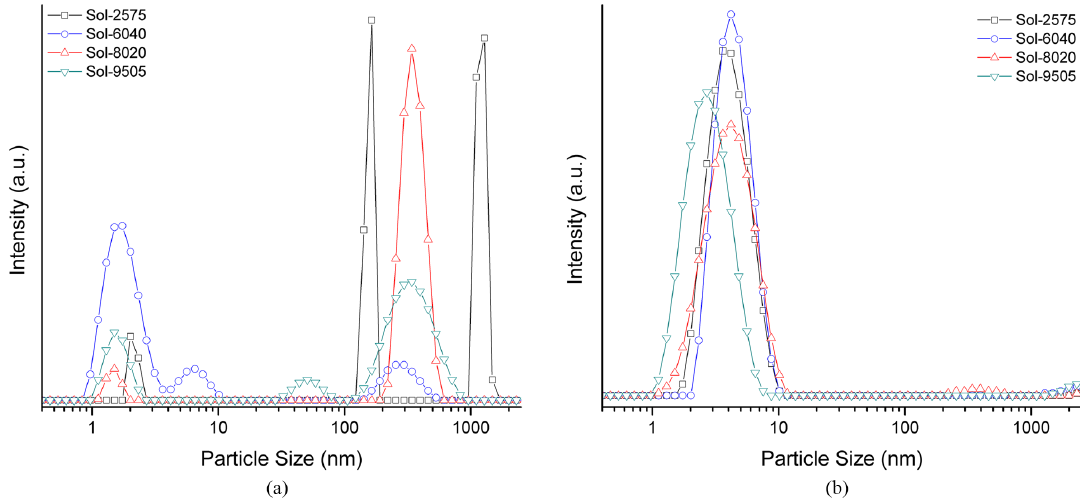
Figure 2. Size distribution curves as recorded by dynamic light scattering for samples aged for (a) 1 day and (b) 25 days after